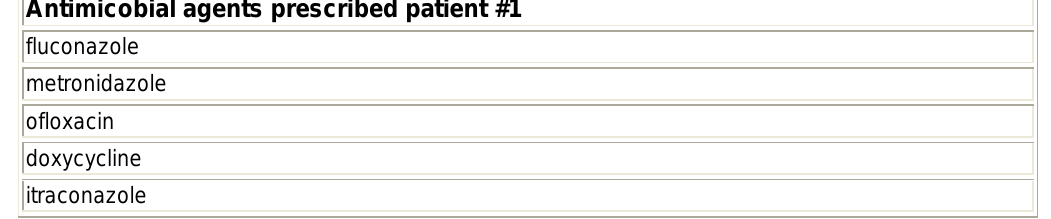
List of all antimicrobial agents prescribed for patient